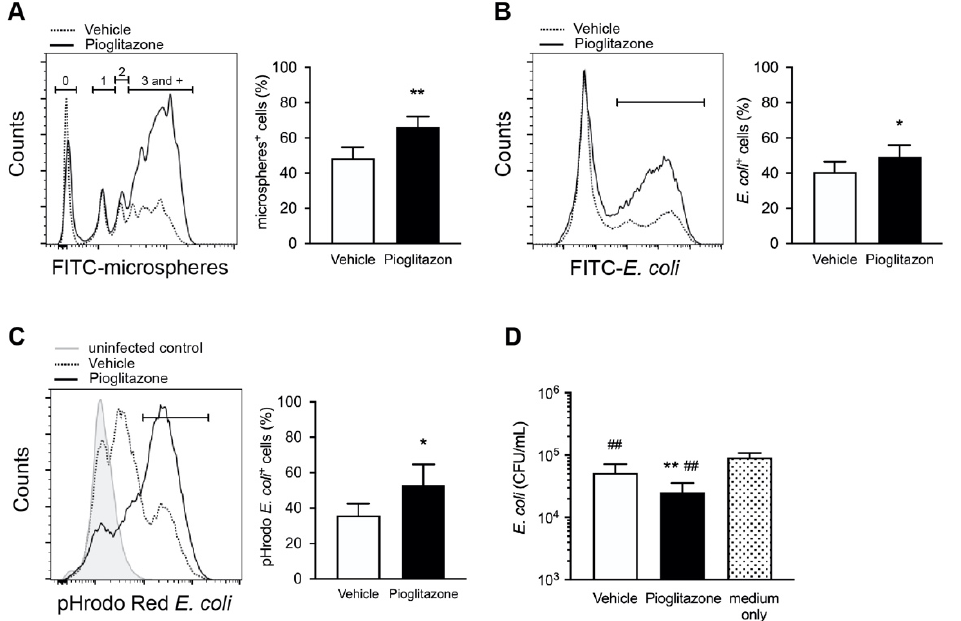
Figure 5. Pioglitazone treatment enhances bacterial clearance in burn-injured mice. ( A , B ) Isolated hepatic immune cells 3 h after treatment were incubated with fluorescein-conjugated microspheres or E. coli for 30 min and stained with anti-CD45, anti-CD11b, and anti-F4/80 antibodies, followed by the analysis of phagocytic activity in CD11b + F4/80 high KCs via flow cytometry. ( A ) Representative flow cytometry histogram showing uptake of FITC-microsphere by KCs from vehicle and pioglitazone-treated mice after burns. Each peak represents the KC population that has ingested either 0, 1, 2, 3, or more microspheres. Percentage of KCs which has internalized ≥ three microspheres was determined. ( B ) Representative histograms showing phagocytosis of FITC-conjugated E. coli by KCs and percentage of FITC-conjugated E. coli phagocytosing KCs. ( C ) Representative flow cytometry histogram showing a shift in fluorescence intensity of pHrodo E. coli bioparticles in CD11b + F4/80 high KCs. The pHrodo fluorescence increased with decreasing pH (acidification), indicating phagosomal maturity after ingested bioparticles. Percentage of E. coli particle-positive KCs with low pH phagosome in vehicle and pioglitazone-treated mice 20 min post administration of pHrodo E. coli . n = 6 per group. ( D ) In vitro bacterial killing of hepatic immune cells from vehicle or pioglitazone-treated mice. Isolated cells were incubated with E. coli for six hours. As a control, E. coli were incubated without immune cells in the culture medium. n = 6 per group; Data are represented as the mean ± SD; * p < 0.05; ** p < 0.01 vs. vehicle. ## p < 0.01 vs. medium only.